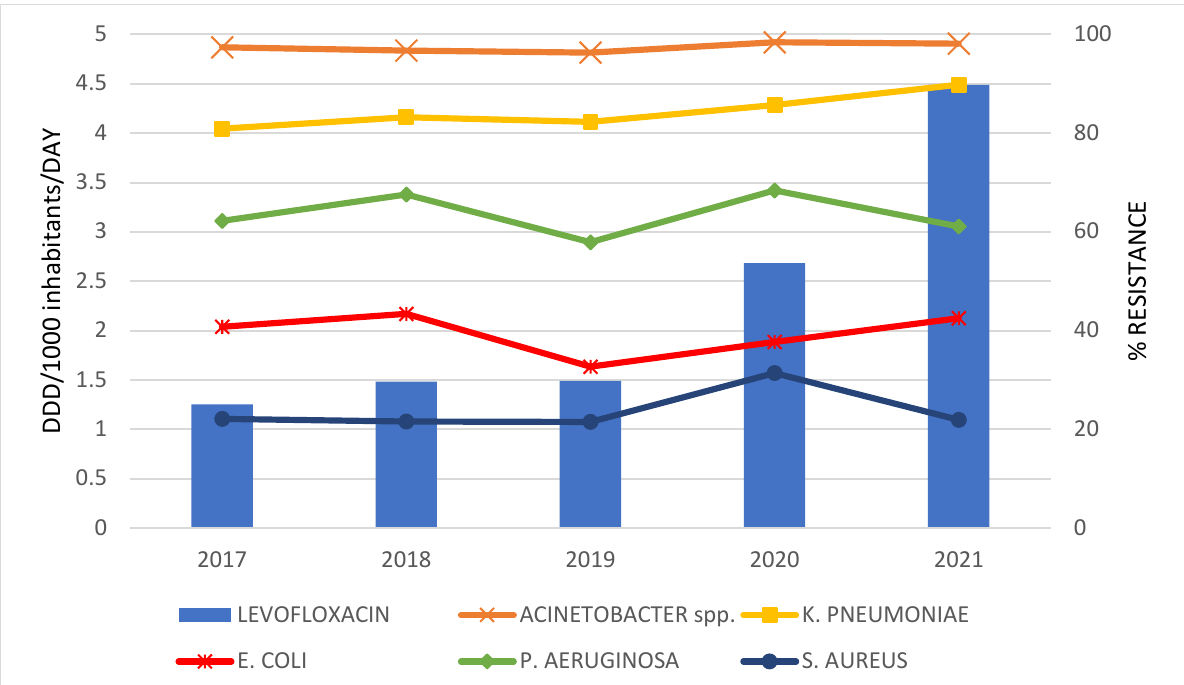
Figure 5. The correlation of levofloxacin consumption and the resistance to levofloxacin in bacteria during 2017 – 2021.